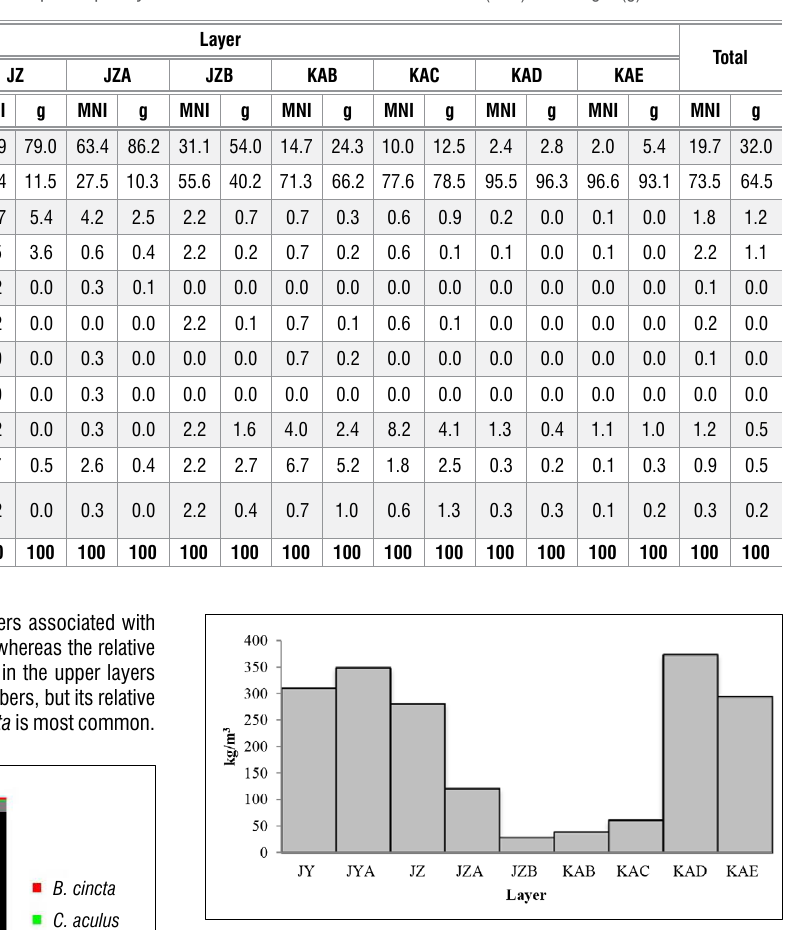
Klipdrift Cave: Relative abundance (%) of each species per layer based on minimum number of individuals (MNI) and weight